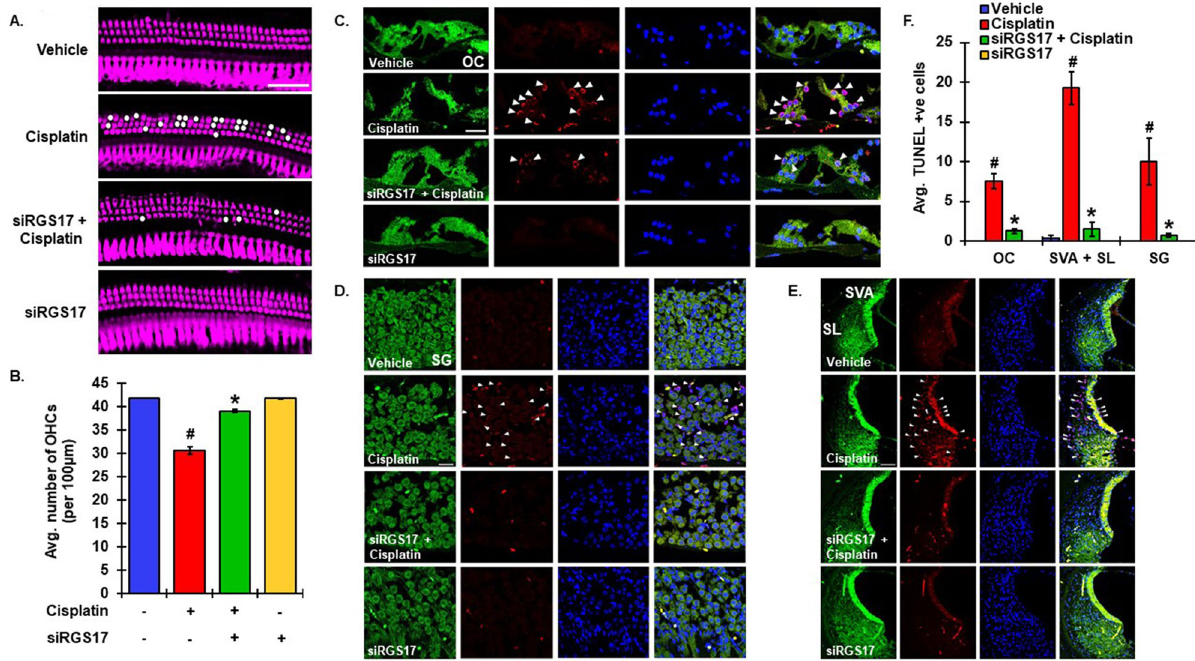
Figure 5. Knockdown of RGS17 inhibits cisplatin-mediated apoptosis in cochlea. ( A ) Male Wistar rats were pretreated with siRGS17 (0.9 μg/ear), followed by cisplatin (11 mg/kg, ip) 48 h later. Rats were sacrificed after 3 days. Cochleae were harvested, fixed, decalcified and micro-dissected and whole mount sections from the basal turns were stained with myosin VIIa (magenta). Representative images showed higher degree of damage to OHCs after cisplatin treatment, compared to siRGS17 pre-treated cochleae. Scale bar represents 25 μm. ( B ) Graphical representation of OHC loss showed significant decrease in number of OHCs in siRGS17 treated animals as compared to cisplatin exposed animals. Bar graphs show the average number of OHCs per 100 µm area. ( C ) Mid-modiolar sections were used for TUNEL staining (red) along with phalloidin immunostaining (green). TUNEL-positive cells as marked by white arrows were observed to be higher in both hair cells and supporting cells of cisplatin treated animals as compared to siRGS17 pretreated cochleae. ( D ) In SG neurons as well as in SVA ( E ), cisplatin produced greater number of TUNEL-positive cells and no distinct TUNEL-positive staining was observed in cochleae treated with siRGS17. Scale bar represents 50 µm (SVA) and 25uM (OC and SG). ( F ) Bar graph from TUNEL assay presented in ( C,D,E ) showed significantly higher number of TUNEL positive cells in animals after cisplatin exposure whereas it significantly decreased in animals pretreated with siRGS17. Data are presented as mean ± SEM. # p < 0.01 versus vehicle, *p < 0.01 versus cisplatin, N ≥ 4, one-way ANOVA ( B ) and two-way ANOVA ( F